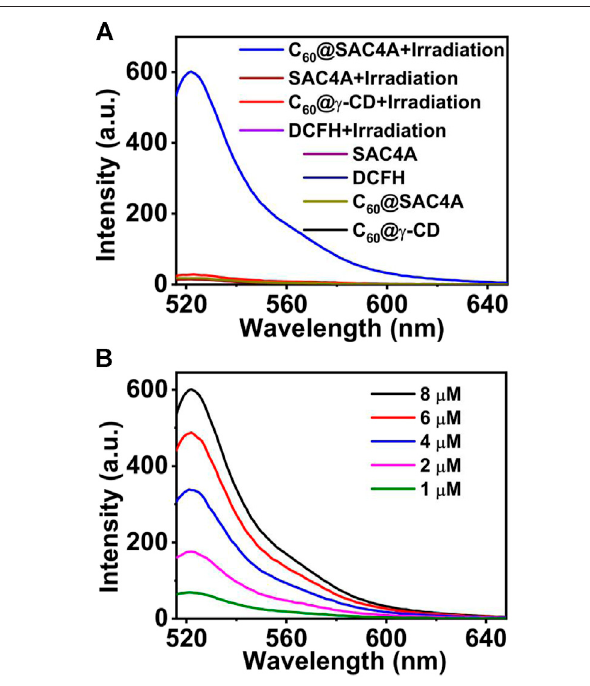
FIGURE 4 | (A) Fluorescence response of DCFH to ROS treated with C